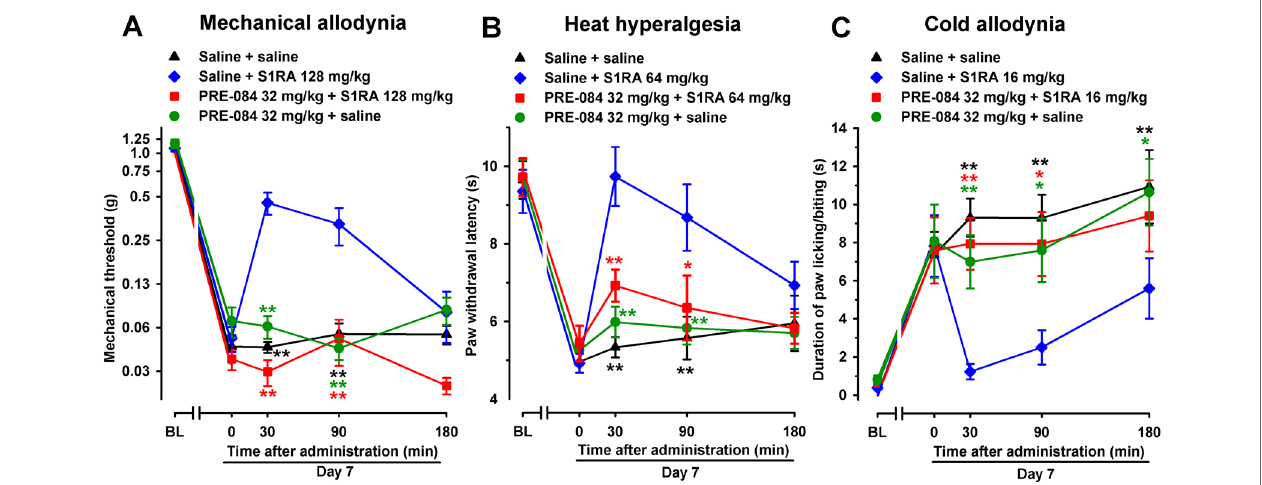
FIGURE 4 | The σ 1 receptor agonist PRE-084 reversed the effects of the σ 1 receptor antagonist S1RA in female WT mice with SNI 7 days after surgery. Mechanical allodynia (A) , heat hyperalgesia (B) , and cold allodynia (C) were evaluated 1 day before (baseline, BL) and 7 days (day 7) after surgery, in the paw ipsilateral to the surgery. On day 7, the responses to test stimuli were recorded immediately before (time 0) and at several times (30, 90, and 180 min) after injection of the drugs or saline. Each point and vertical line represent the mean ± SEM of the values obtained in 8–14 animals. Statistically significant differences in comparison to the saline+S1RA group: * P < 0.05; ** P < 0.01 (two-way repeated-measures ANOVA followed by Bonferroni